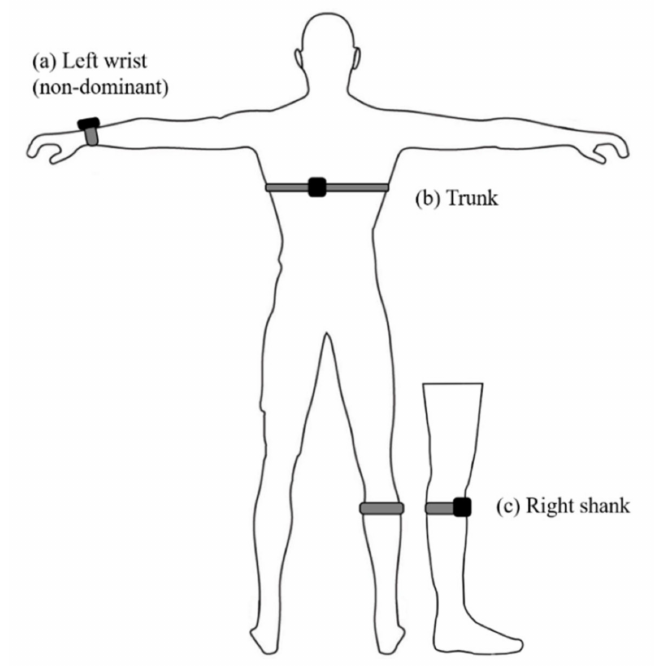
Figure 1. Accelerometers were placed on the left wrist ( a ), trunk ( b ) and shank ( c